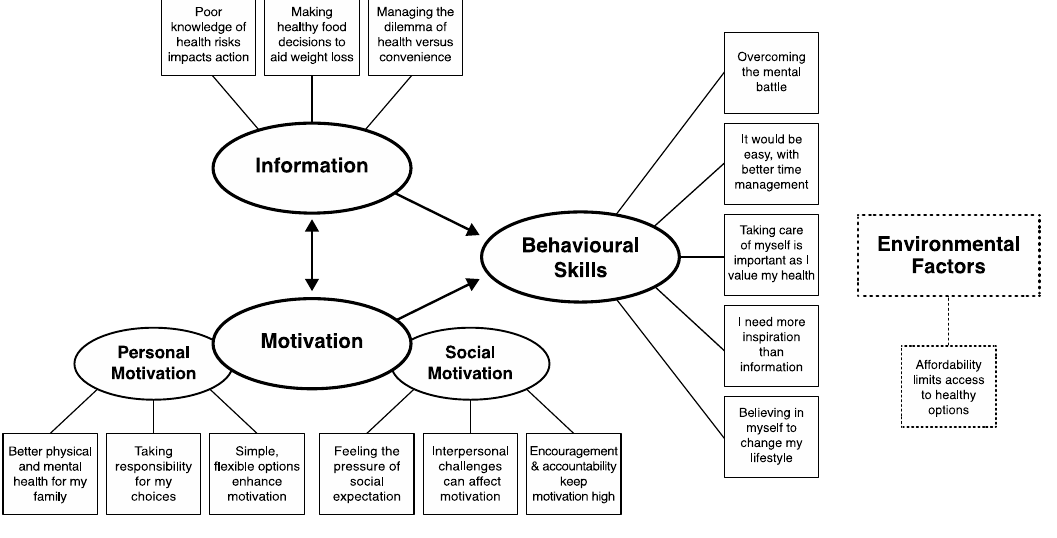
Figure 1. Thematic Figure 1. Thematic map.